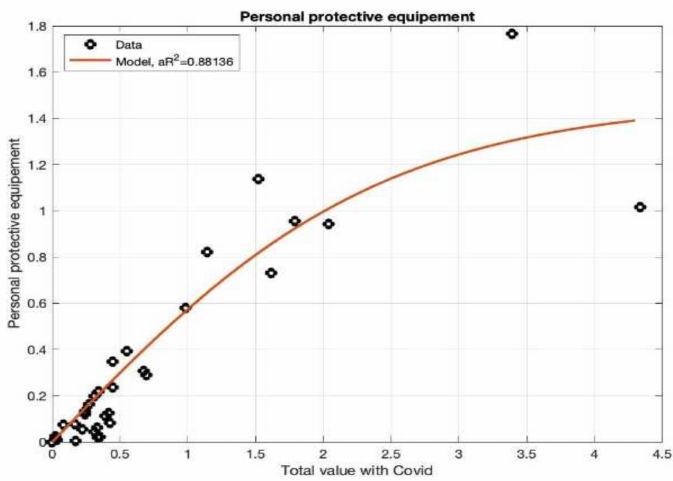
Figure 12. Correlation relationship of total COVID funding vs. personal protective equipment.